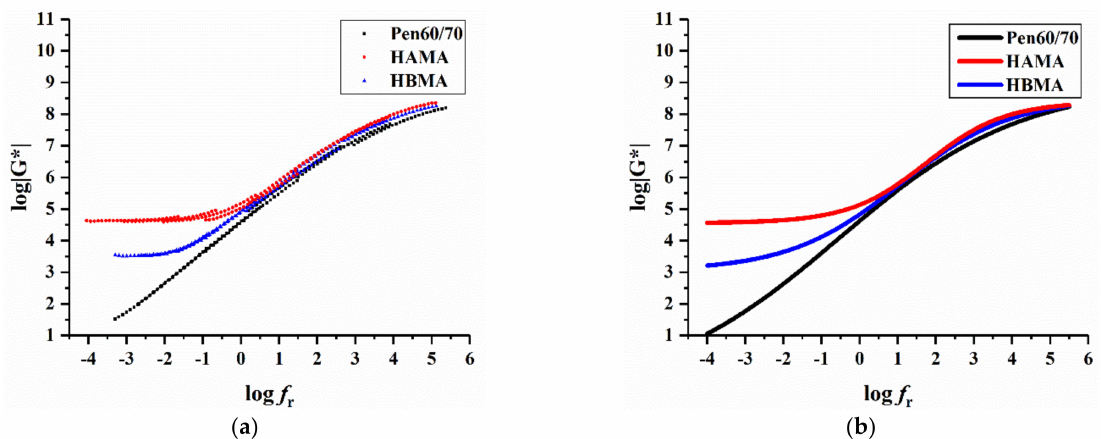
Figure 9. Master curves of test binders at 40 ◦ C: ( a ) scatters of transformed result data and ( b ) regression curves of sigmoidal model.